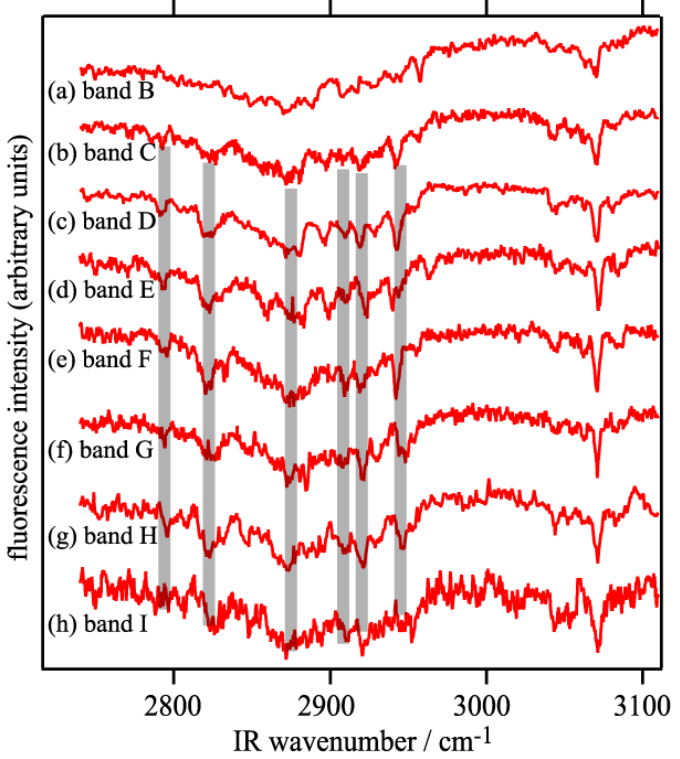
Figure 13. IR-UV DR spectra of bands B-I in the CH stretching region for B18C6-(H Thick lines highlight similar features in the spectra of bands C-I at ~2790, ~2820, ~2870, ~2910, ~2920, and ~2940 cm -1 . Figure adapted from Reference